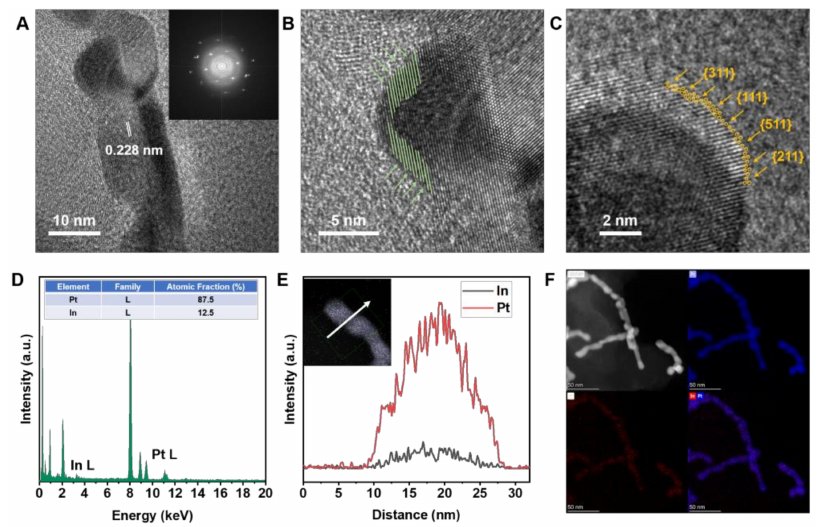
Figure 2. ( A ) HRTRM image, ( B , C ) atomic-resolution HRTEM images, ( D ) STEM-EDS, ( E ) SETM-EDS line scan profile, and ( F ) STEM-EDS elemental mappings of Pt 89 In 11